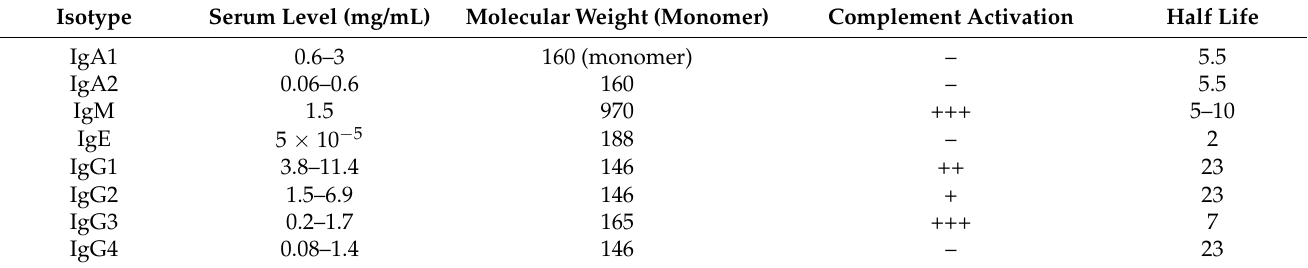
Table 1. Antibody isotypes concentrations in sera and complement activation ability [83]. Designed